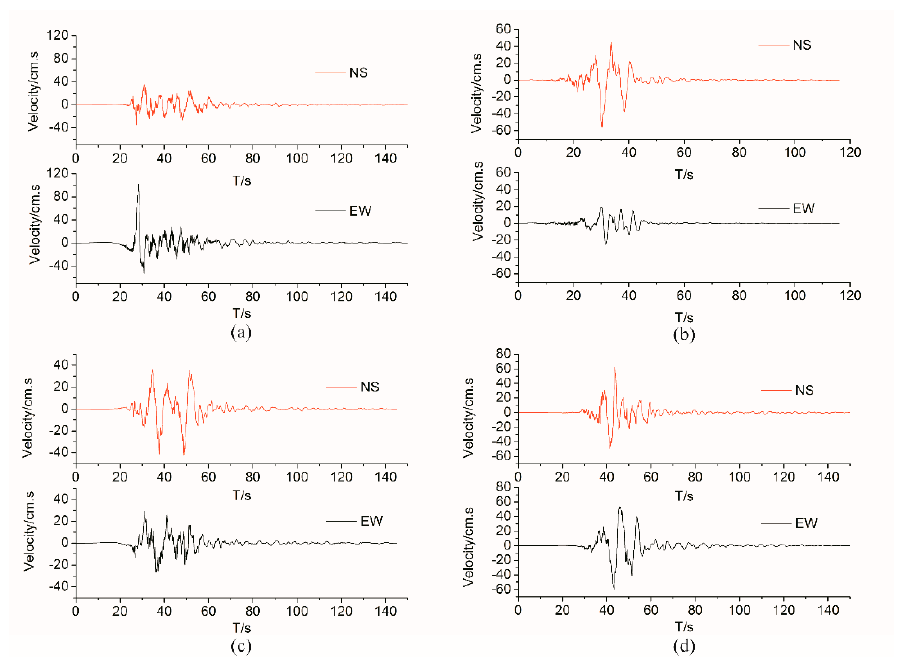
Figure 4. The typical single and multiple pulse waveforms: ( a ) TCU075, ( b ) NSY, ( c ) TCU060, and ( d ) TCU128. ( d )